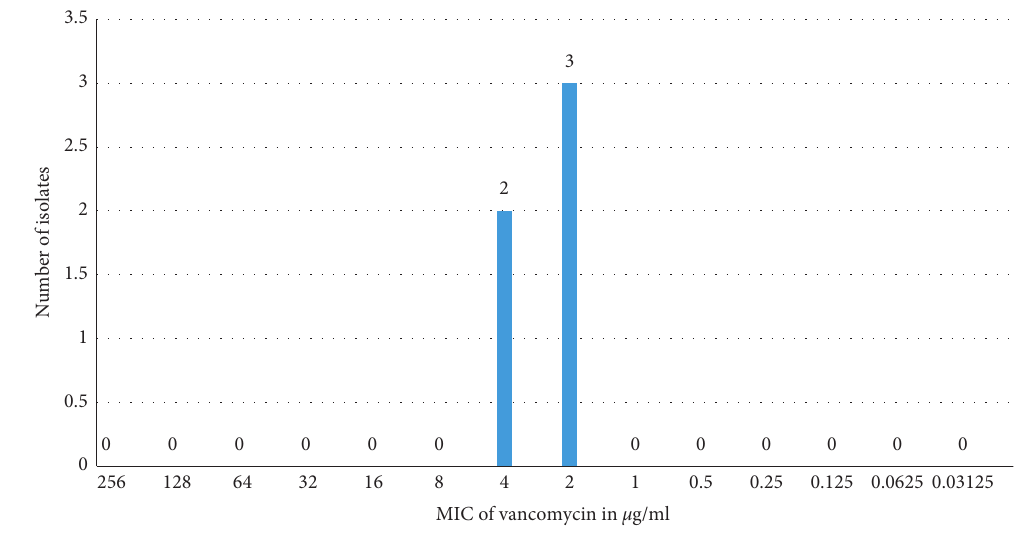
Figure 1: MIC of vancomycin for Staphylococcus aureus ( n � 5). Table 5: Complications and outcome of IE patients ( n � 17).